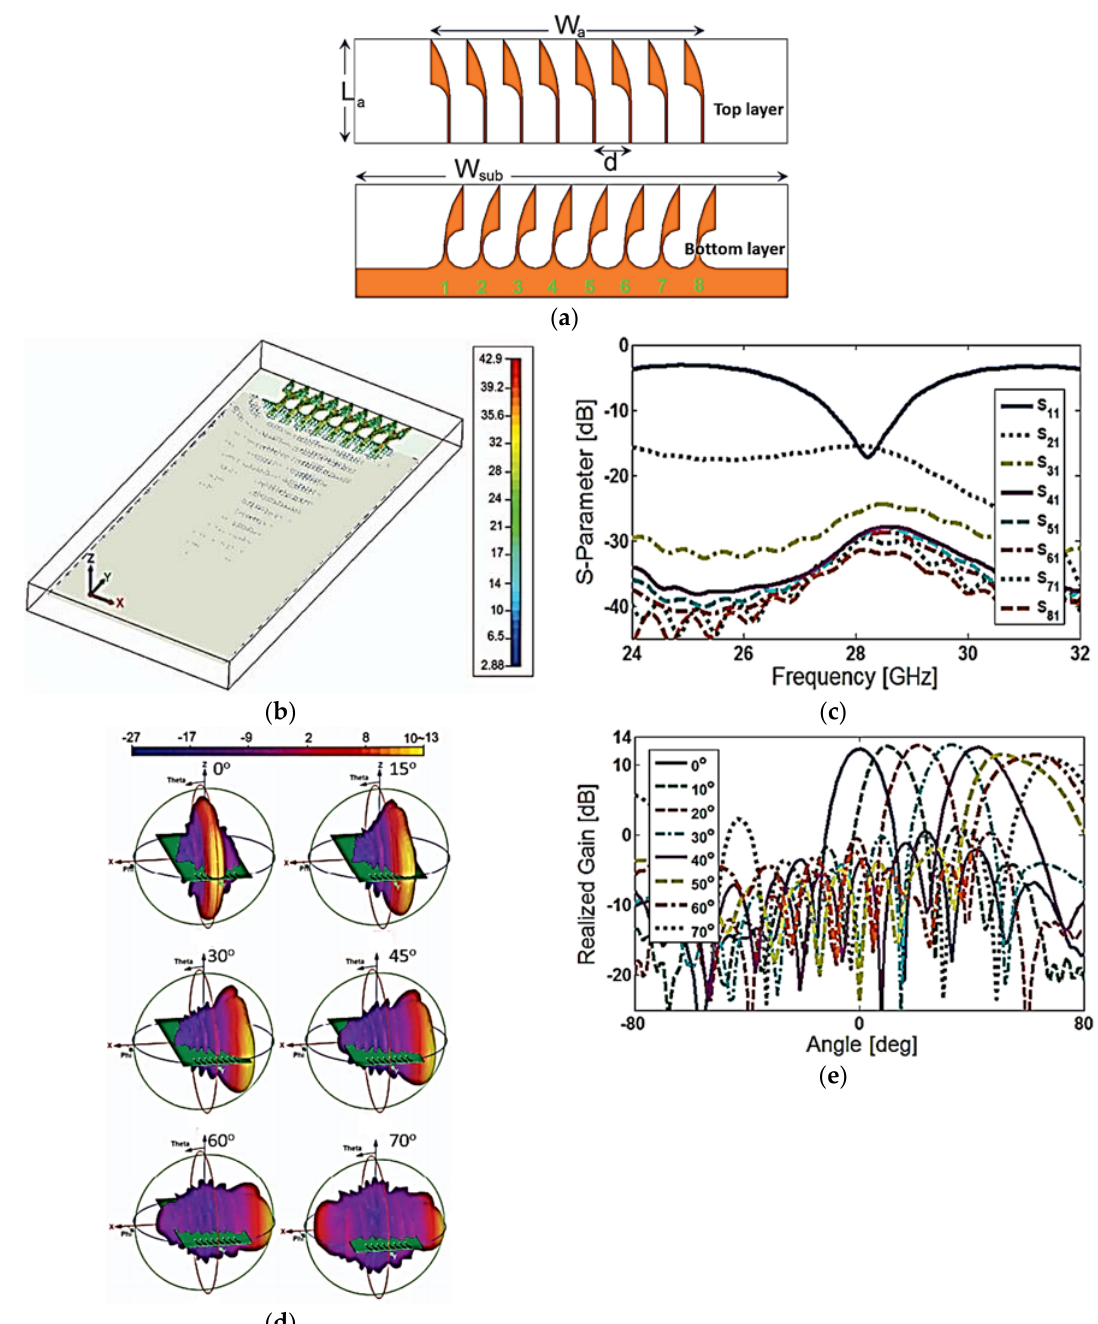
Figure 9. ( a ) Geometry of the Vivaldi phased ‐ array antenna. ( b ) Surface ‐ current distribution of proposed phased ‐ array antenna at 28 GHz. ( c ) Simulated S ‐ parameters of the proposed Vivaldi antenna array elements. ( d ) Radiation patterns of the antenna at different scanning angles. ( e ) Realized gain patterns of the antenna at different scanning angles. (Redrawn from [48]).